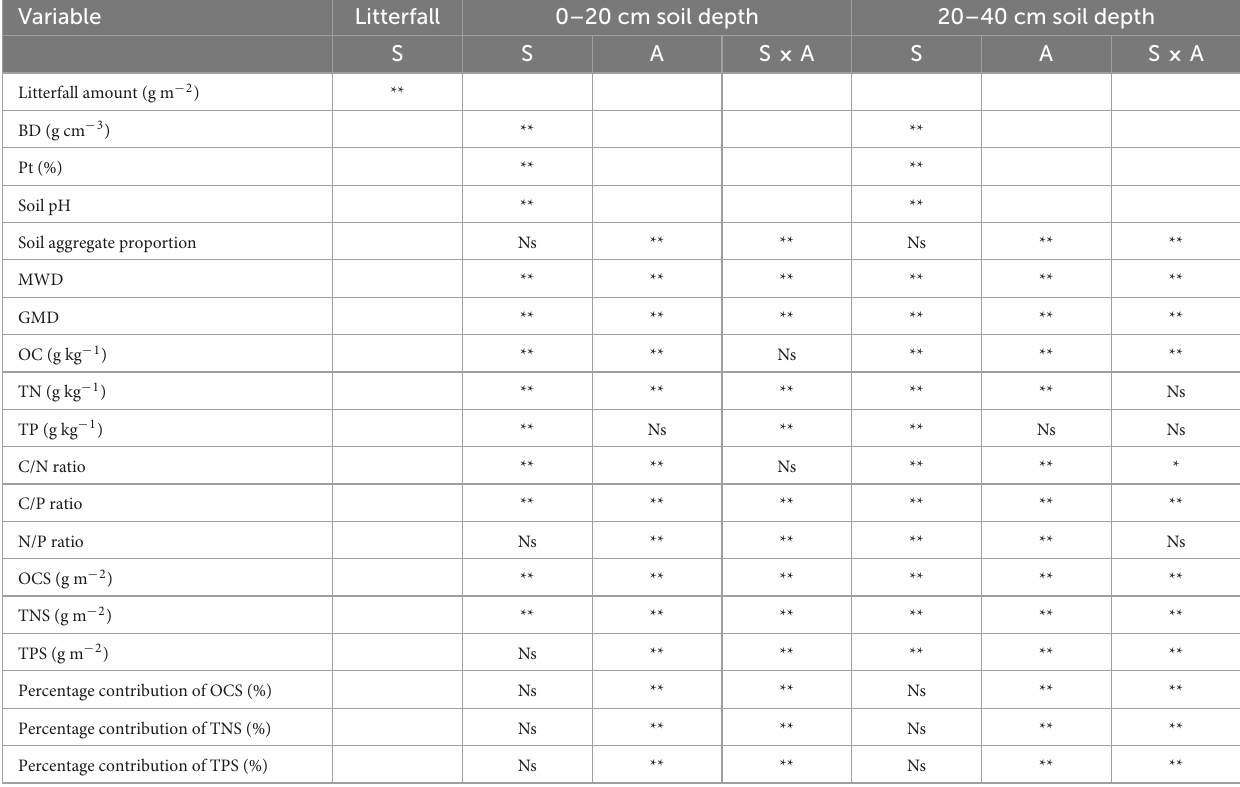
TABLE 3 Litterfall and soil properties as influenced by aggregate size and stand type in Chinese fir plantations.